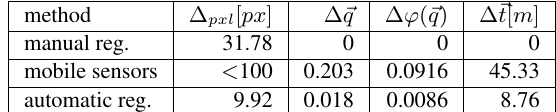
Table 3: Comparative accuracy of initial sensor data, manual- and automatic registration with respect to ∆ pxl , rotational errors ∆ (cid:126)q and ∆ ϕ ( (cid:126)q ) , and ∆ (cid:126)t . Mam Tor, March 2015